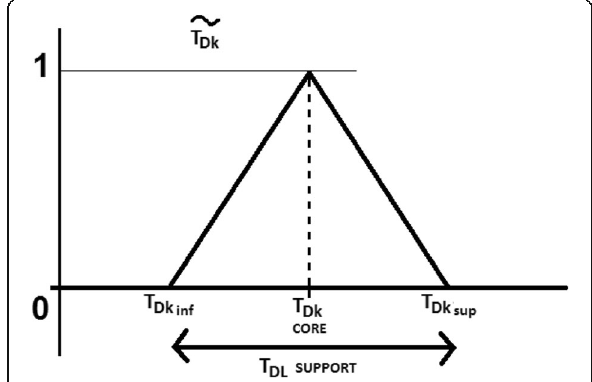
Fig. 9 Diagram of Fuzzy Dwell Times. Triangular